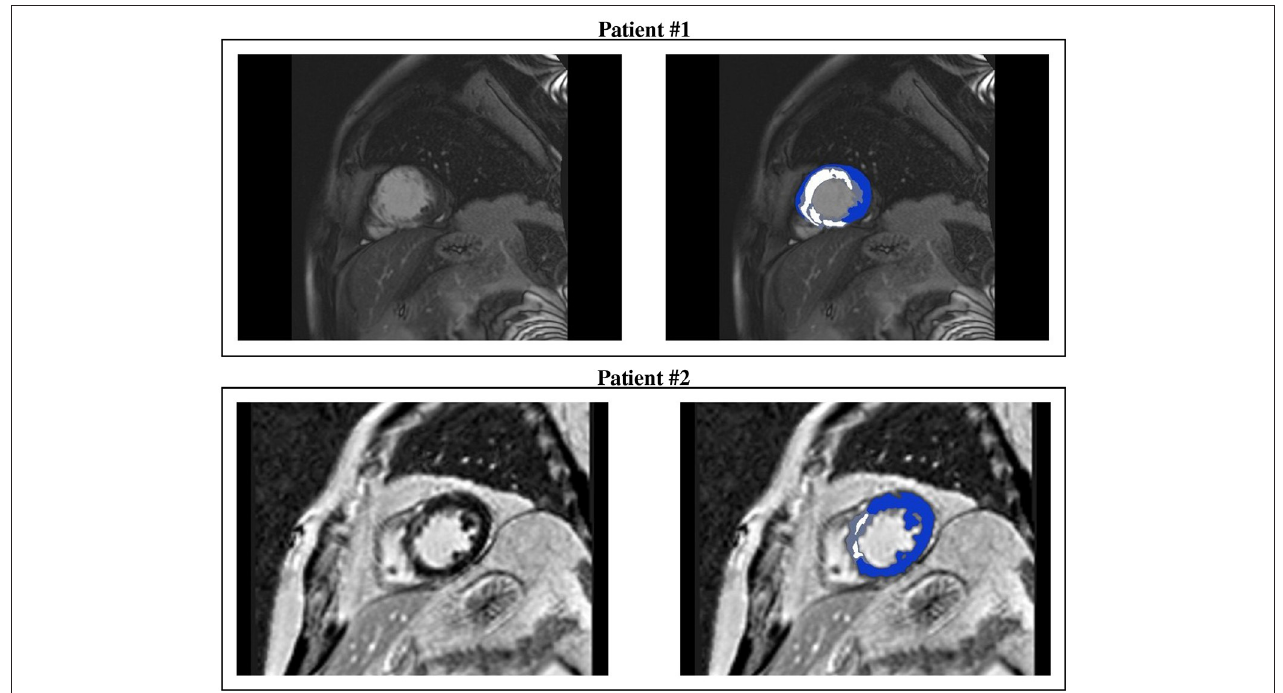
FIGURE 2 | CMR short-axis slices (left) of interest of patients #1 and #2 and the resulting ventricular segmentation (right) into non-infarcted myocardium (blue), border zone (gray), and scar